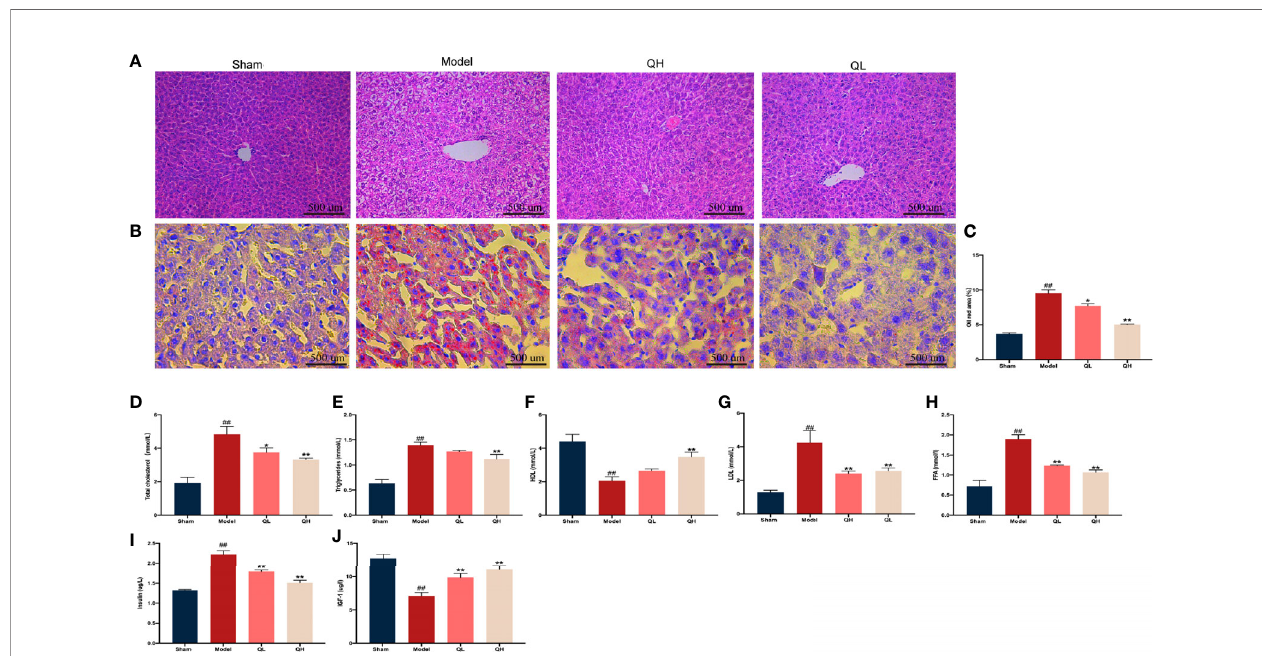
FIGURE 7 | Effects of quercetin on lipid and glucose metabolism in mice that underwent orchiectomy. (A) The effects of quercetin on liver tissue morphology, visualized by H&E staining. (B) Oil-Red O staining of the liver, and (C) the percentage of lipid droplet area analysis. The serum levels of markers of lipid metabolism including (D) total cholesterol, (E) triglycerides, (F) high-density lipoprotein (HDL), (G) low-density lipoprotein (LDL), and (H) free fatty acid (FFA). The serum levels of markers of glucose metabolism including (I) insulin, and (J) insulin-like growth factor-1 (IGF-1). ## p< 0.01 vs. sham group; * p< 0.05, ** p< 0.01 vs. model group.